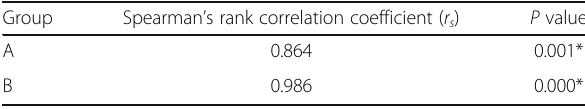
Table 3 Agreement between the two operators in both the groups